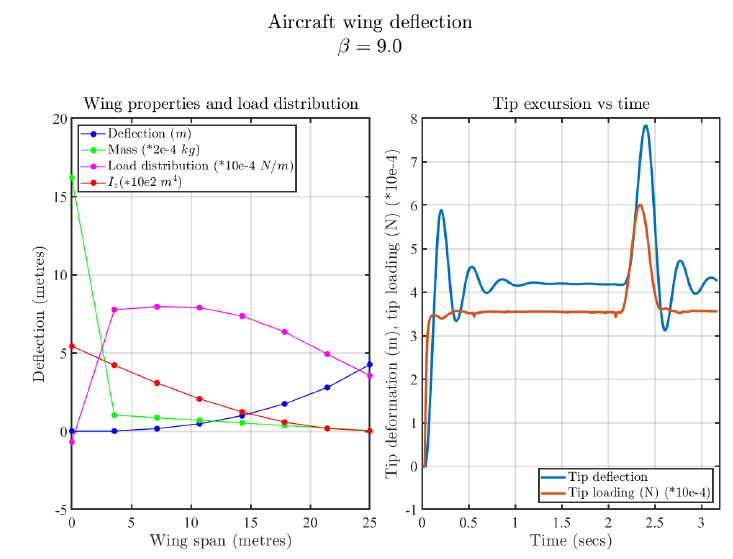
Figure 10. Prediction of the deformation of an aircraft